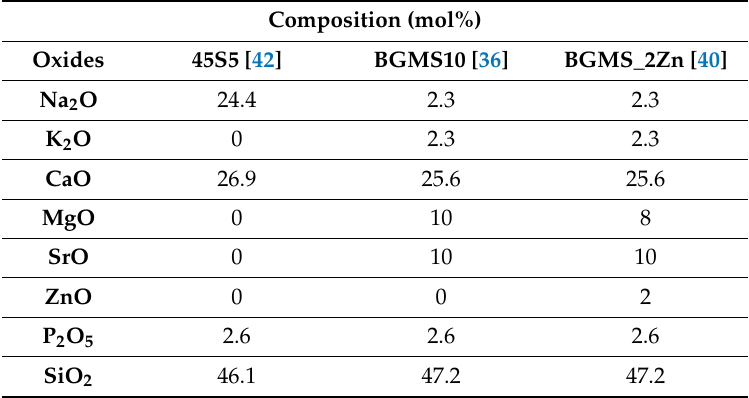
Table 1. Bioactive glass composition in